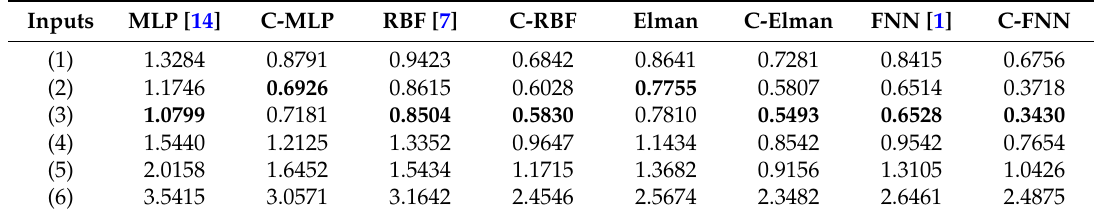
Table 5. The testing RMSE of soft measurement modeling for effluent BOD with different input